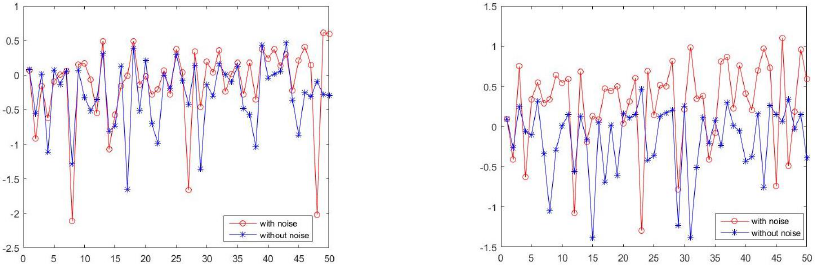
Figure 1. The ratios | c i | / s i and | ˆ c i | / s i for the design matrices of order 50 × 101 for ( r , σ 2 ) = ( 0.9,0.25 ) ( left ) and ( r , σ 2 ) = ( 0.999,1 ) ( right